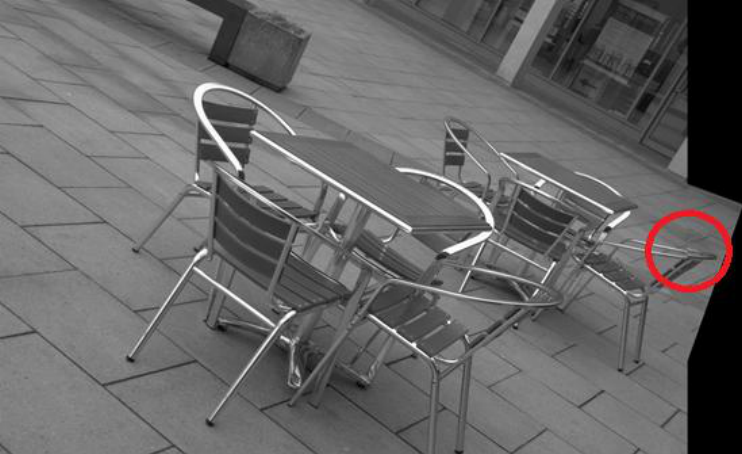
Figure 17. Image registration result for the image pair 12 of the database using IBR alone; the region inside the red circle indicates that better registration is